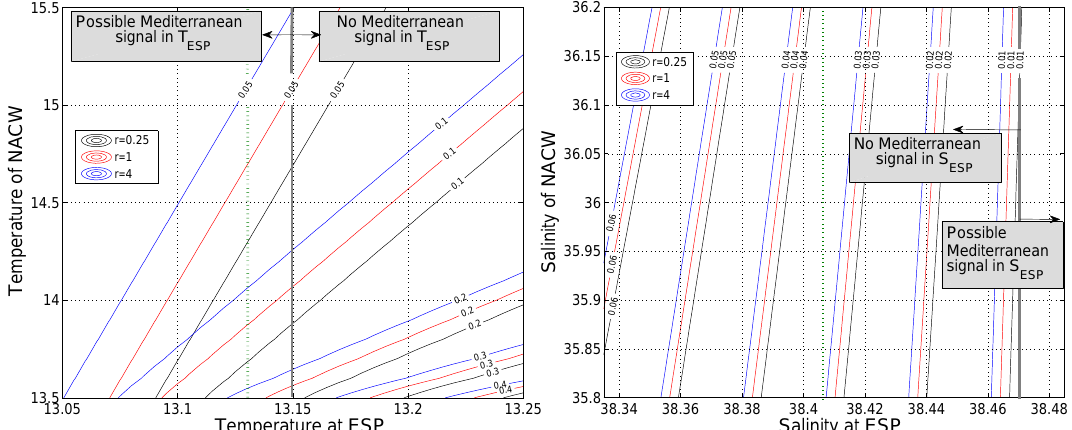
Figure A2. Left: contours of the fraction α NAC in the mixing (Eq. A3) as a function of North Atlantic Central Water (NACW) and final mixed water at ESP temperatures for three different values of the ratio r (see legend; see also text for details). The green dashed line is the mean temperature at ESP in our data set, whereas the thick solid grey line represents the “threshold” value for keeping the chances of detecting, at least partially, the weak Mediterranean signals in the outflow at ESP. Right: same as left panel except for